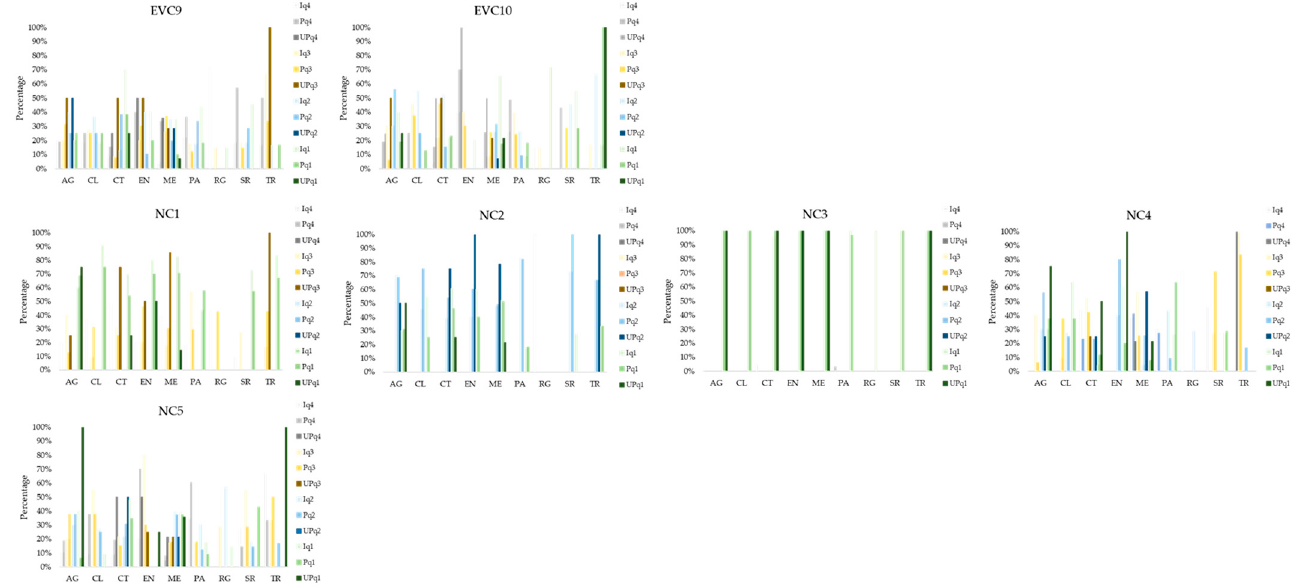
Figure A4. Comparison of the percentages of municipalities for different metropolitan cities in Sicily based on the quartiles of indicators for environmental and natural capital, and the NSIA classification. (Authors’ elaboration.)